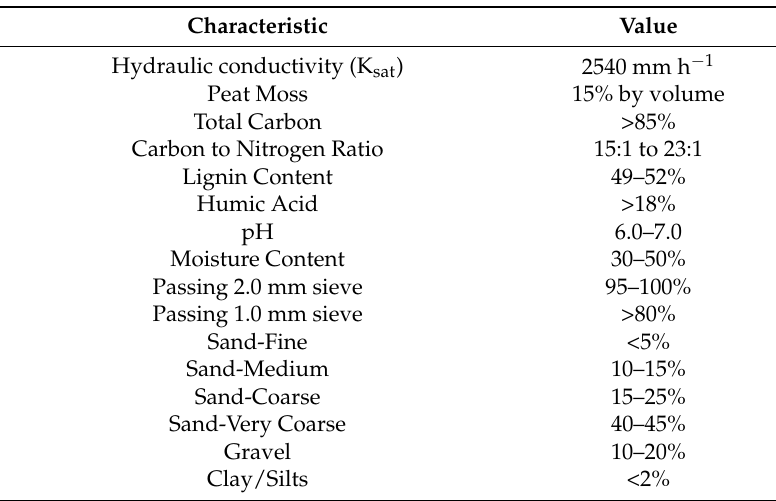
Table 1. High flow media